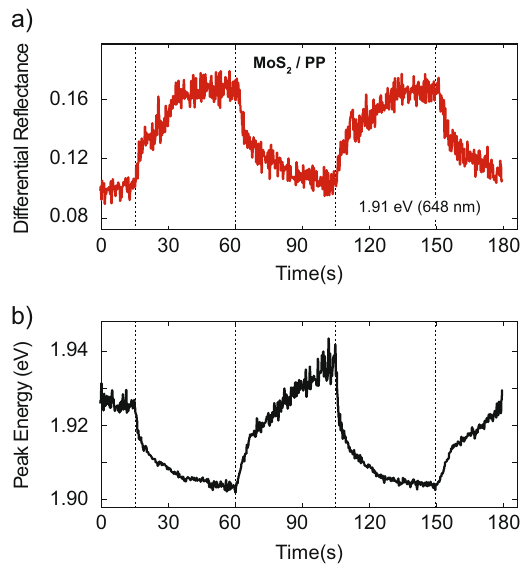
Fig. 5 a Differential re fl ectance measured at a wavelength of 648 nm on single-layer MoS 2 deposited on PP as a function of time with periodical heating and cooling cycles of the substrates from 30 to 75 °C. Each differential re fl ectance spectrum has been integrated for 300 ms. b Energy of exciton A as a function of